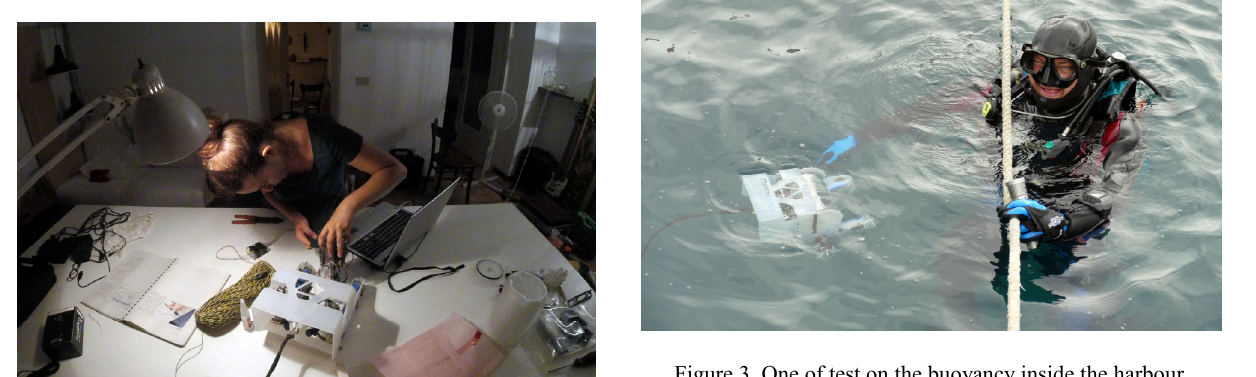
Figure 3. One of test on the buoyancy inside the harbour.